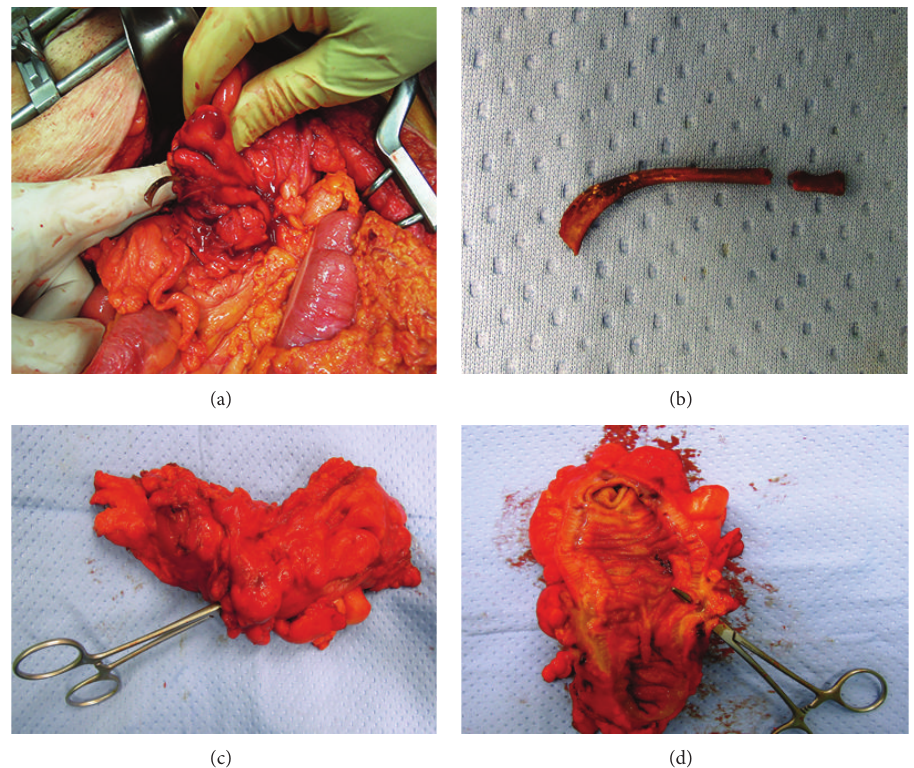
Figure 5: Intraoperative pictures showing the foreign body perforating the pseudotumour, (a) chicken bone, (b) resected colon with evidence of the fistula, and the thickening of the wall (c, d).